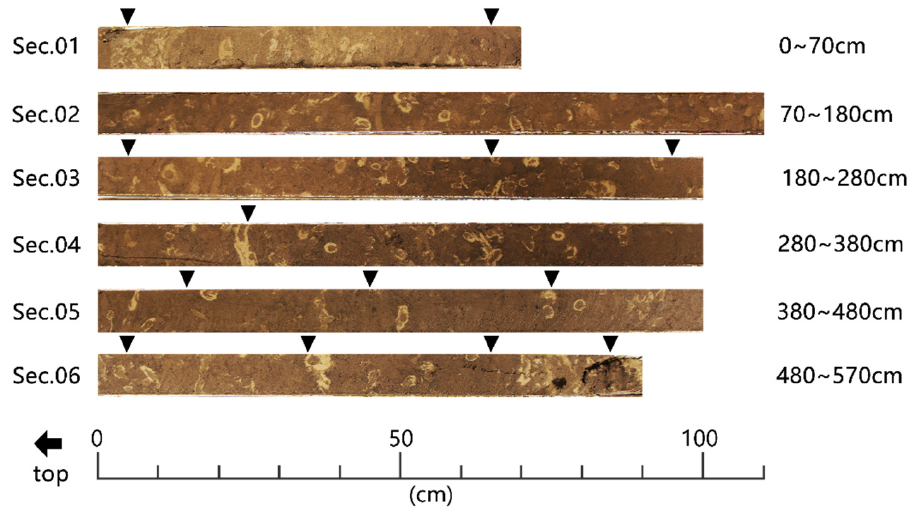
Figure 2. Photographs of GC04 core. The black inverted triangle represents the sampling location for clay analysis.